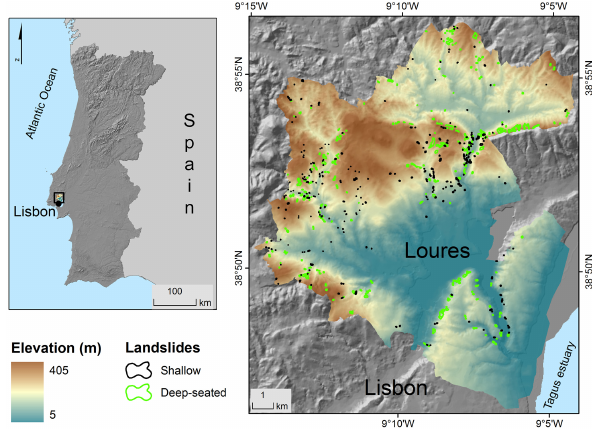
Figure 1. Loures municipality location, elevation, and location of the 686 inventoried